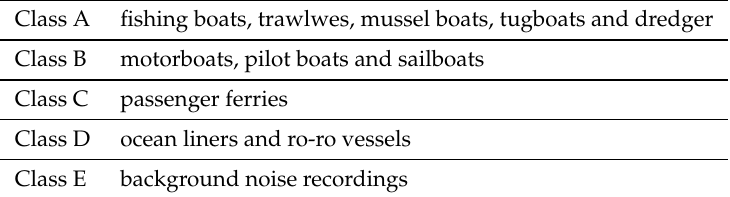
Table 1. The 11 vessel types were merged into four experiment classes and one background noise class.